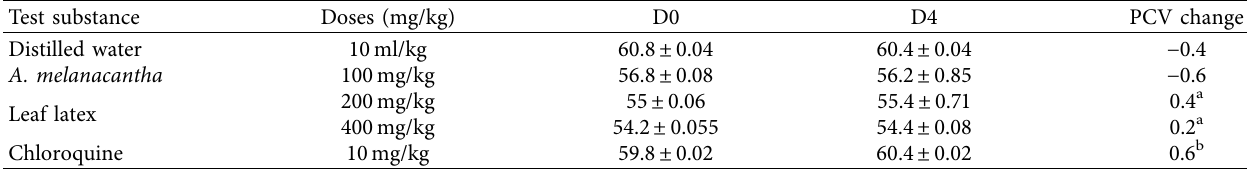
Table 5: Effect of Aloe melanacantha leaf latex on packed cell volume of Plasmodium berghei infected